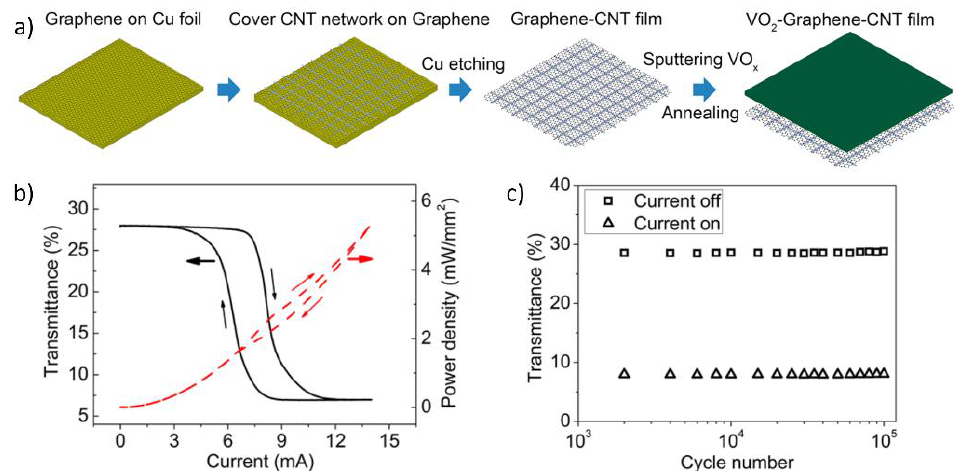
Figure 5. ( a ) Schematic of fabrication of VO 2 /graphene/carbon nanotube (VGC) film; ( b ) Characteri- zation of VGC film with current-dependent transmittance (1500 nm) (black line) and the correlated power consumption (red line); ( c ) Reliability measurement of the VGC films over 100,000 cycles with regard to current pulses. Reproduced with permission from [93]. Copyright 2015, American Chemical Society.